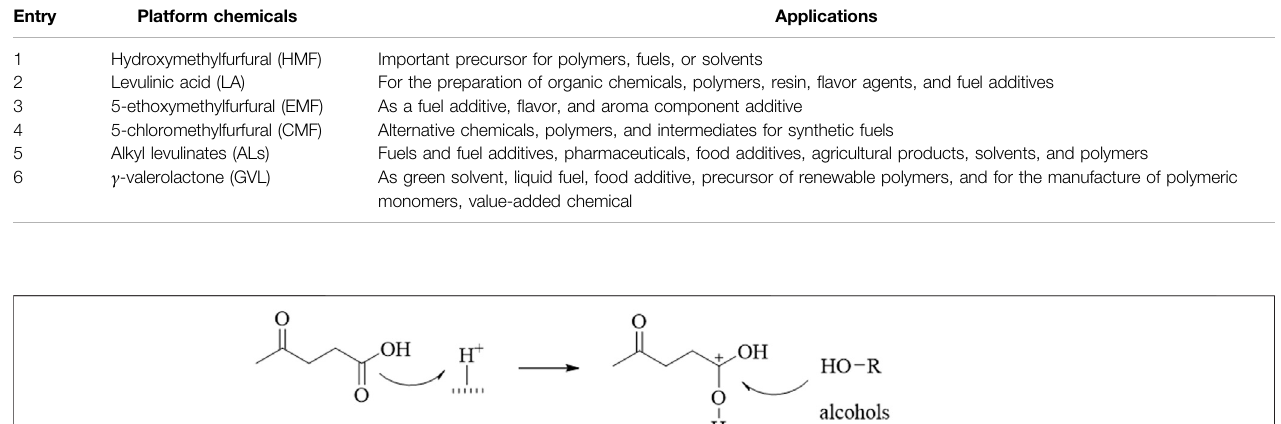
TABLE 1 | Potential platform chemical applications.